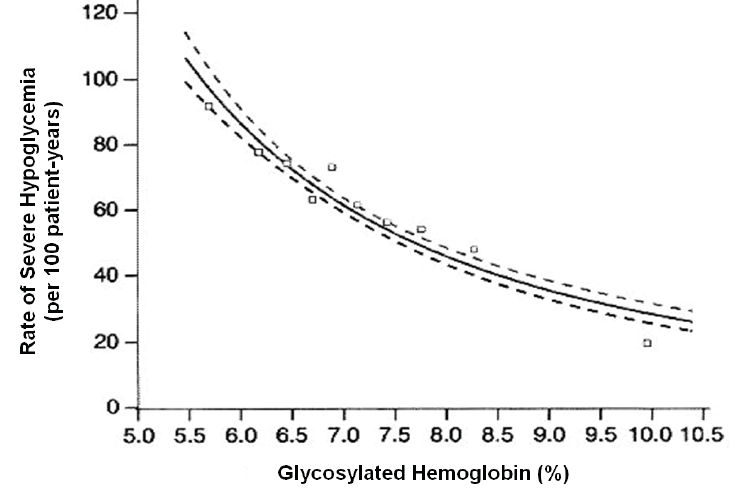
Figure 2. Rate of Severe Hypoglycaemia in Patients Receiving Intensive Therapy; According to their Mean Glycosylated Haemoglobin Values during the DCCT Trial